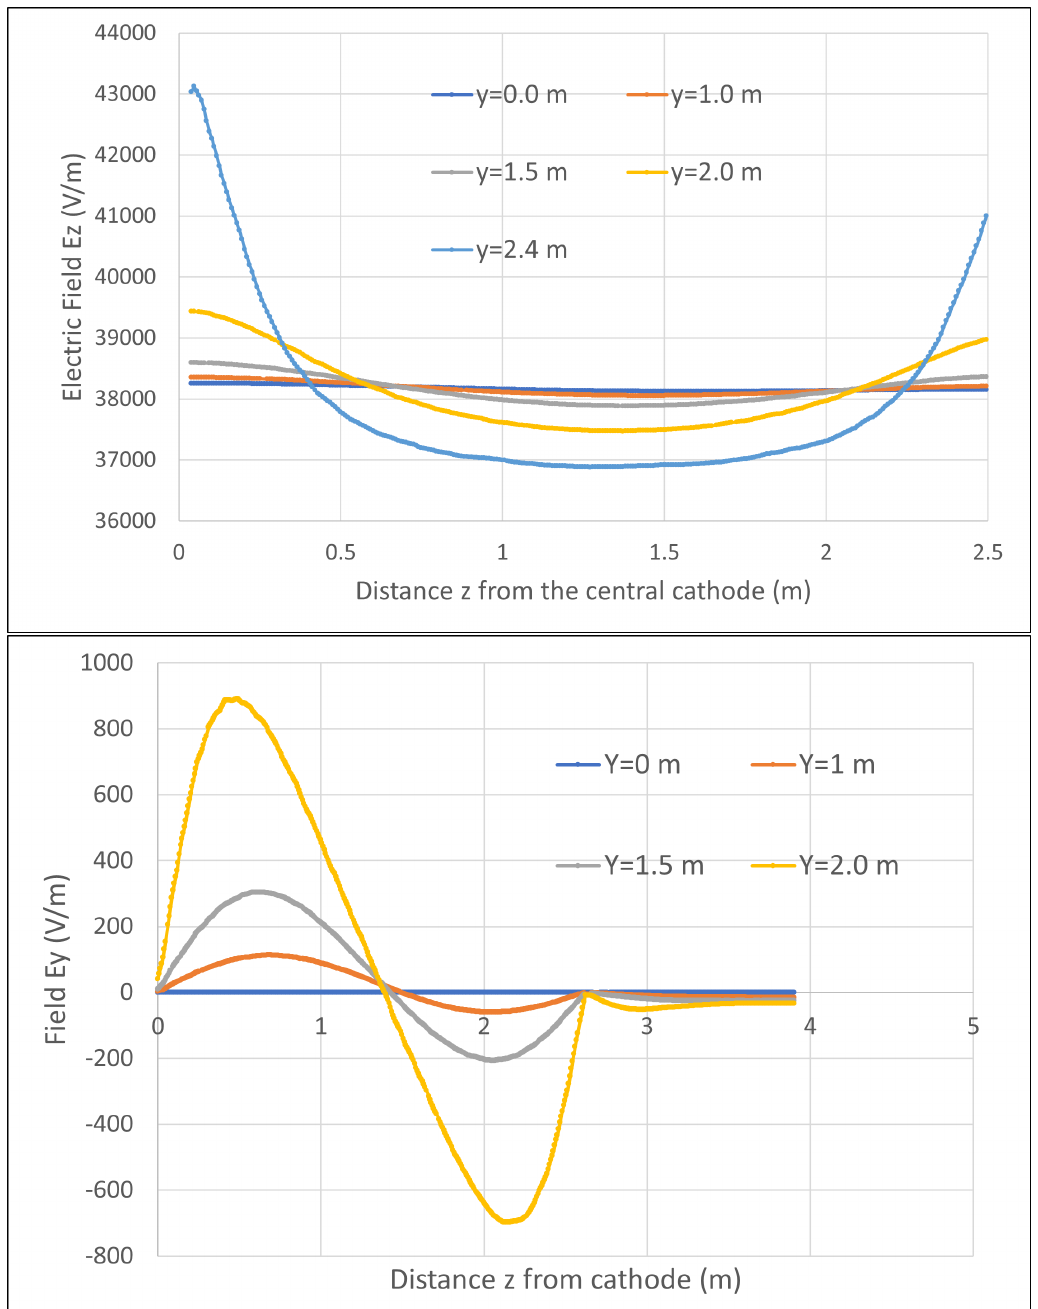
Figure A4. Electric field component E z for the dual-anode